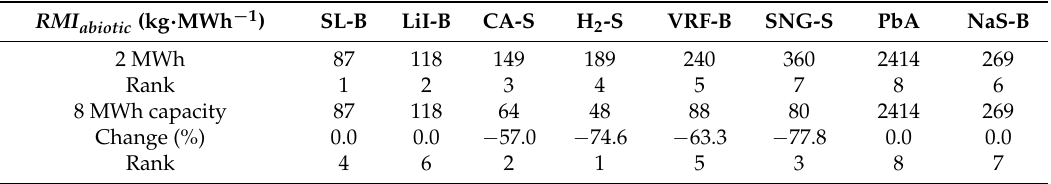
Table A5. Ranking of electrical energy storage technologies for RMI abiotic with 2 and 8 MWh storage